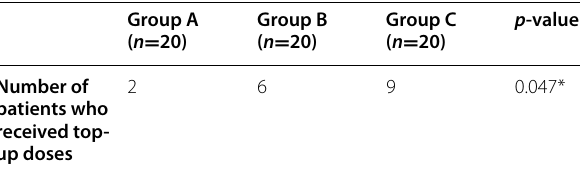
Table 3 Comparison between the three groups as regard number of patients who received top-up doses